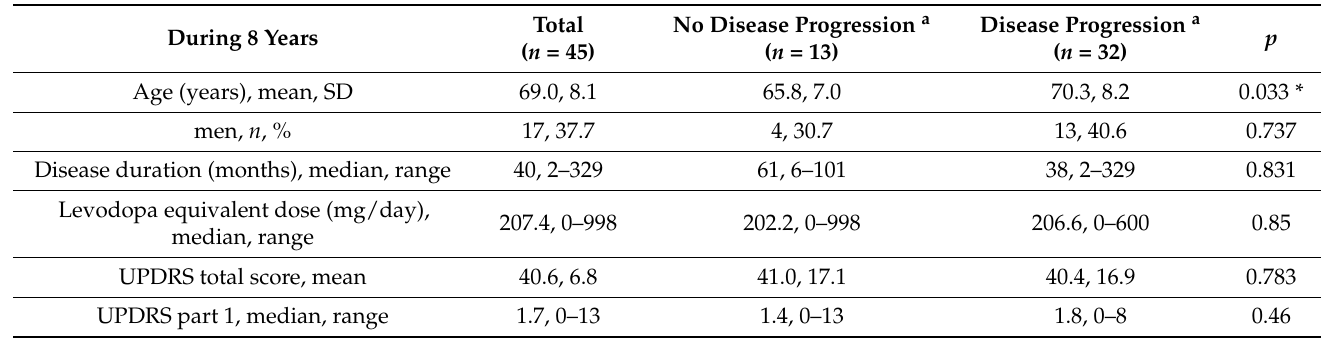
Table 2. Basic characteristics of subjects with Parkinson’s disease in our